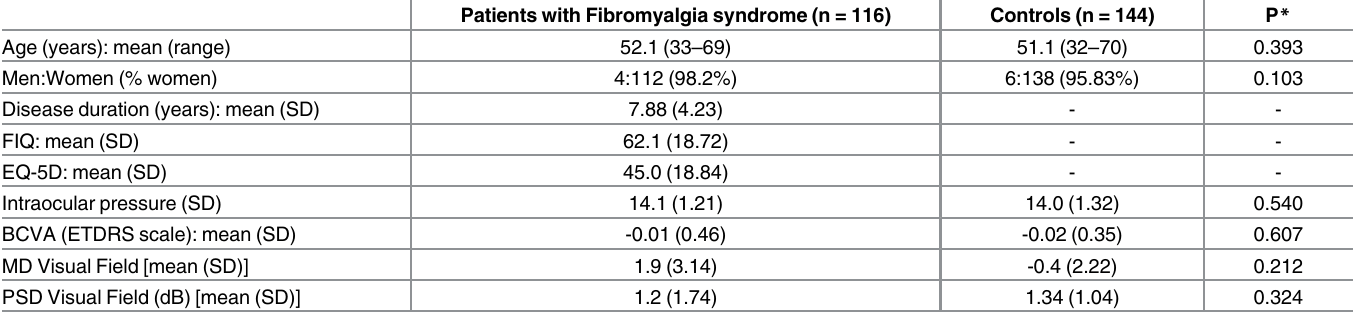
Table 1. Epidemiologic and disease characteristics of 116 patients with fibromyalgia syndrome and 144 controls included in the study, and statis- tical significance of the comparisons between the groups (P). Patients with Fibromyalgia syndrome (n =